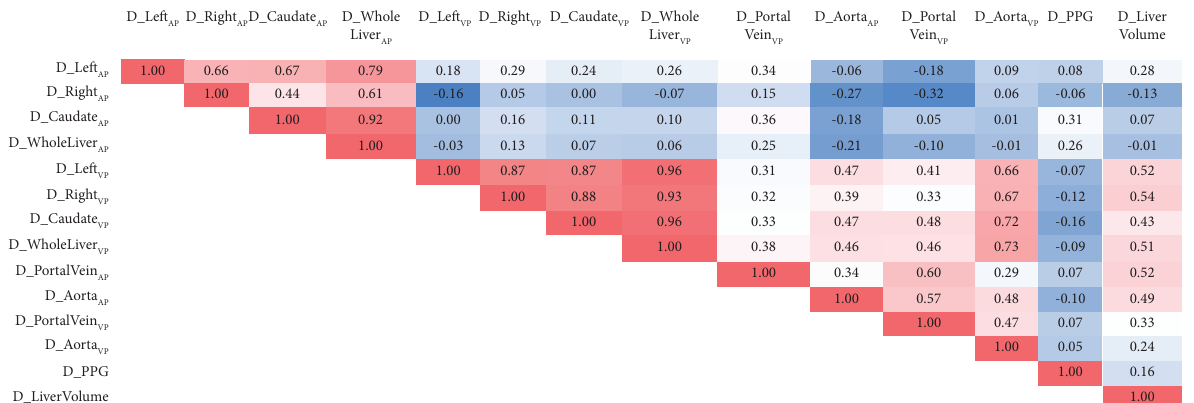
Figure 1: Te Spearman correlation analysis of the change in ID, PPG, and liver volume pre-andpost-TIPS. AP: arterial phase; VP: venous phase; PPG: portal pressure gradient. D_ represented the diference in iodine density before and after TIPS; the bold presented the P value less than 0.05.